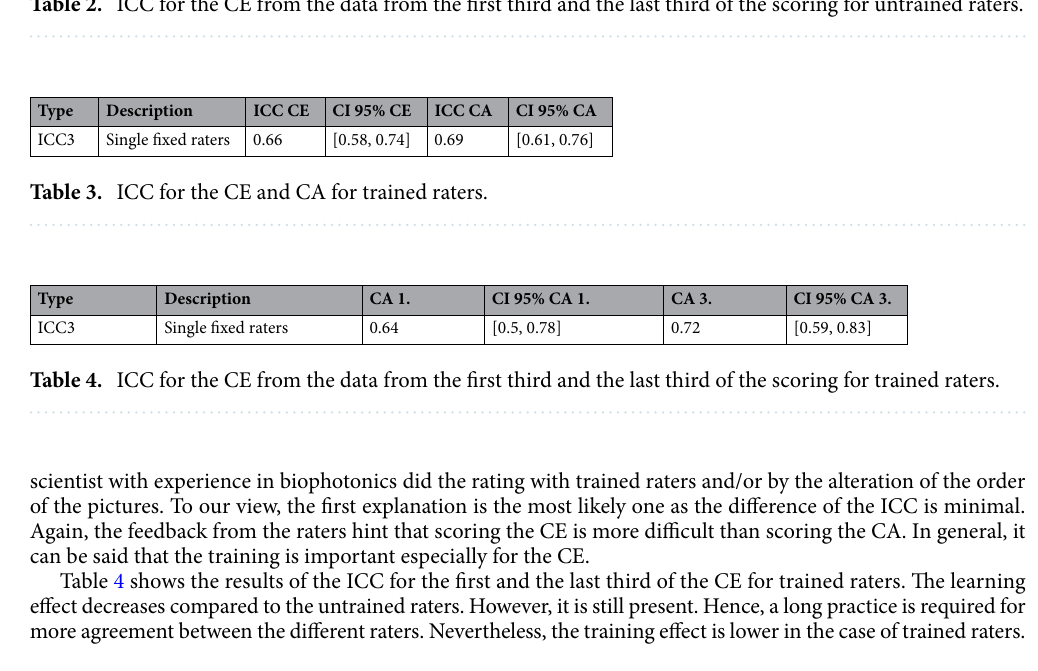
Table 2. ICC for the CE from the data from the first third and the last third of the scoring for untrained raters.